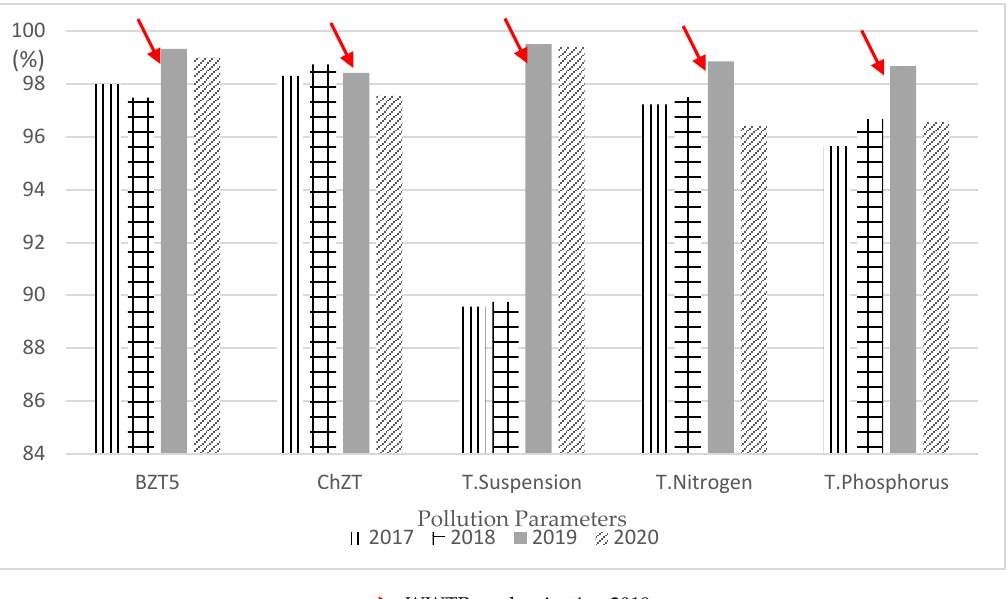
Figure 2. Efficiency of the sewage treatment plant operation in individual years of operation, with specification of chemical parameters. Source: Own elaboration.